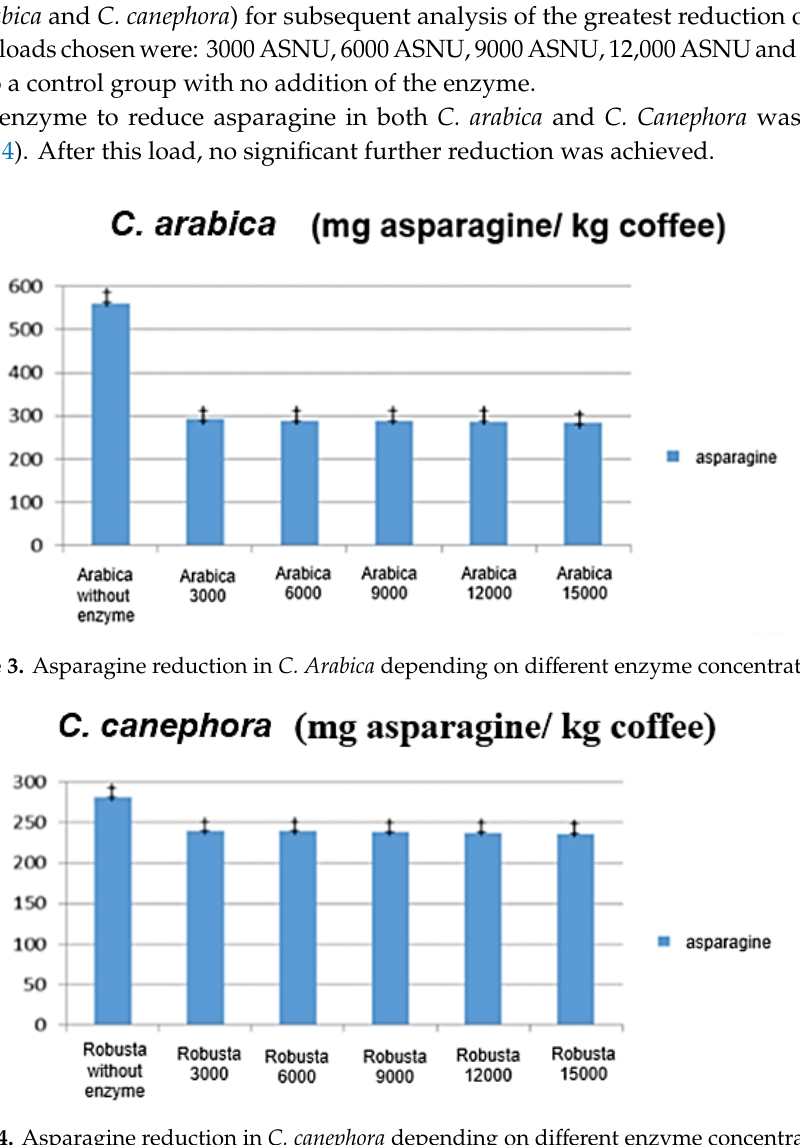
Figure 4. Asparagine reduction in C. canephora depending on different enzyme concentrations.